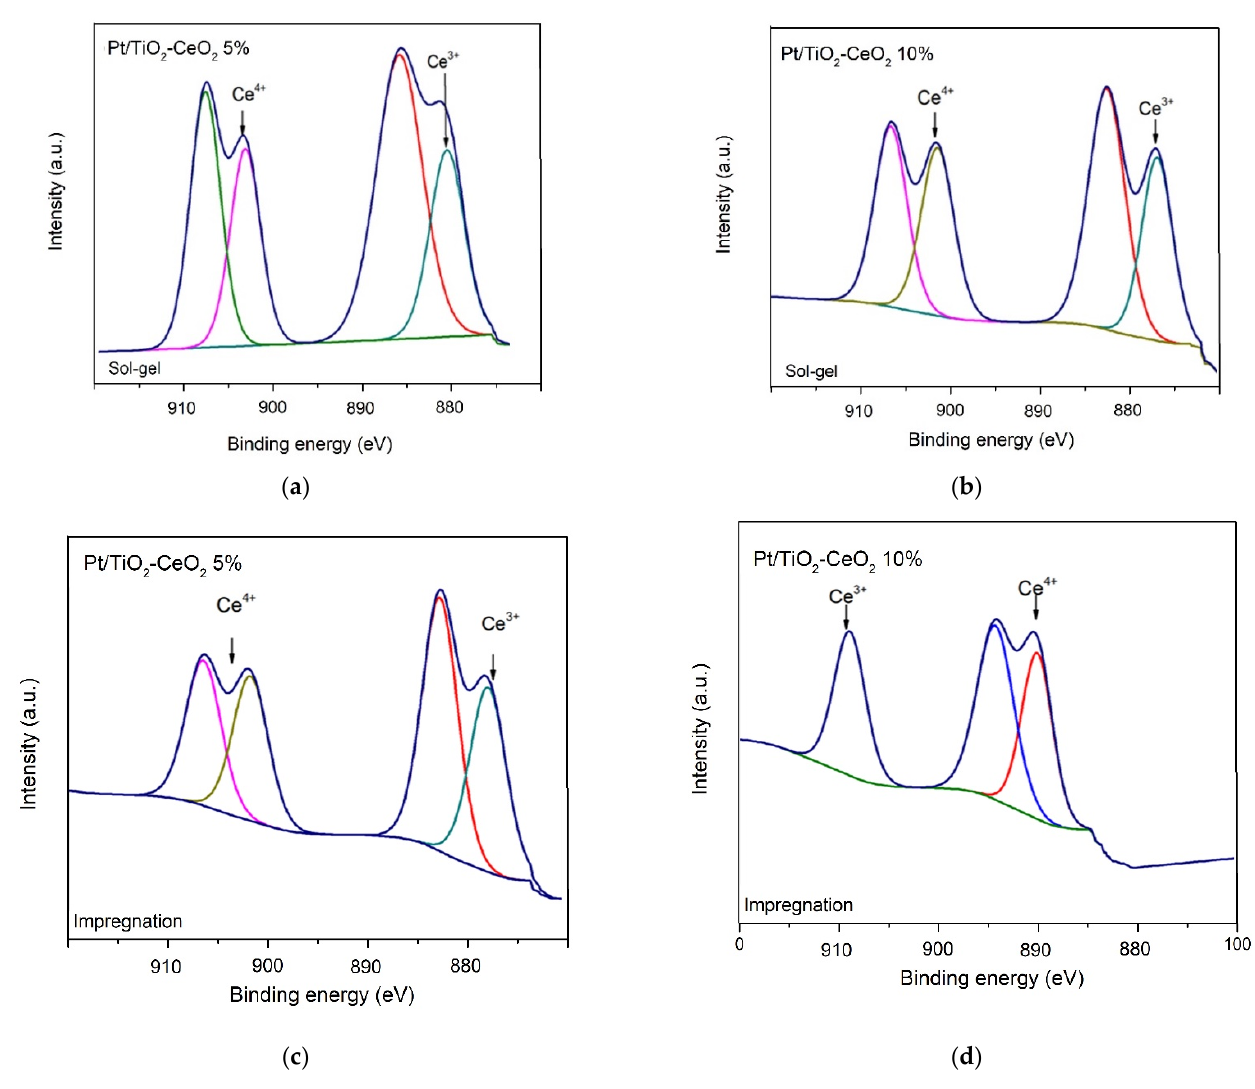
Figure 5. XPS spectra (Ce 3d region) for photocatalyst ( a ) Sol-gel Pt/TiO 2 -CeO 2 5%, ( b ) Sol-gel Pt/TiO 2 -CeO 2 10%, ( c ) Impregnation Pt/TiO 2 -CeO 2 5%, and ( d ) Impregnation Pt/TiO 2 -CeO 2 10%.